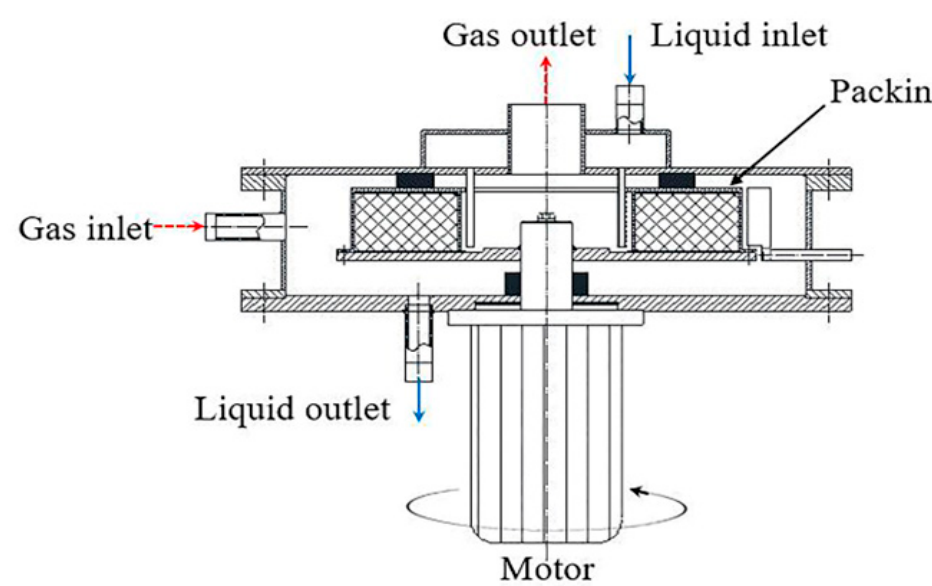
Figure 1. Schematic diagram of rotating packed bed (RPB) (counter-currently).